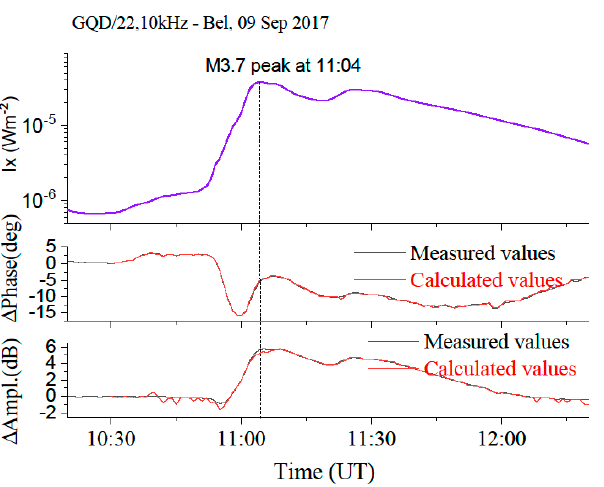
Figure 5. Simultaneous variations of X ‐ ray flux, delta amplitude, and phase of GQD/22.10 signal against universal time during occurrence of M3.7 ‐ class solar flare on 9 September 2017. ( lower panel ) Observed amplitude perturbations on GQD, radio signals measured at the Belgrade station and calculated values. ( middle panel ) Observed and calculated phase perturbations. ( upper panel ) Time variation of X ‐ ray irradiance measured by GOES ‐ 15 satellite.